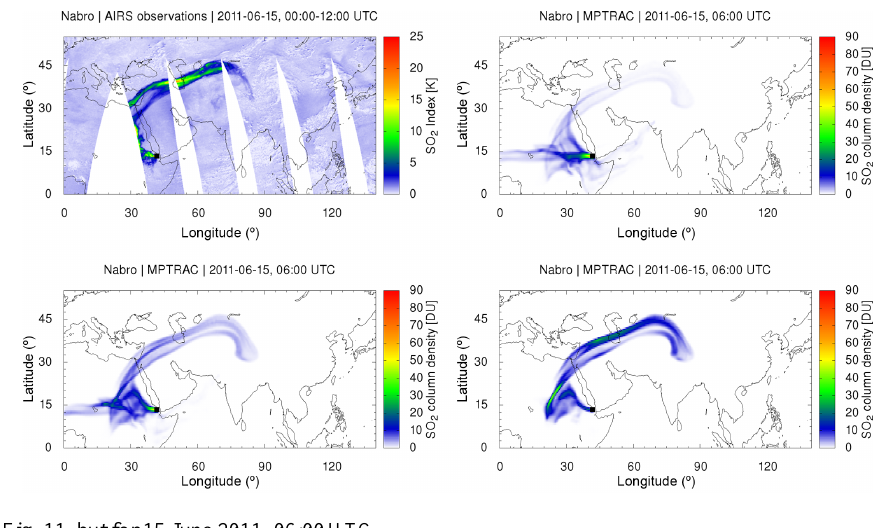
Figure 13. Same as Fig. 11, but for 15 June 2011, 06:00UTC.